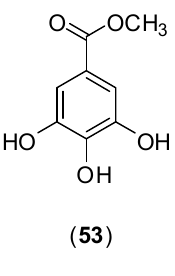
Figure 22. Structure of methyl gallate ( 53